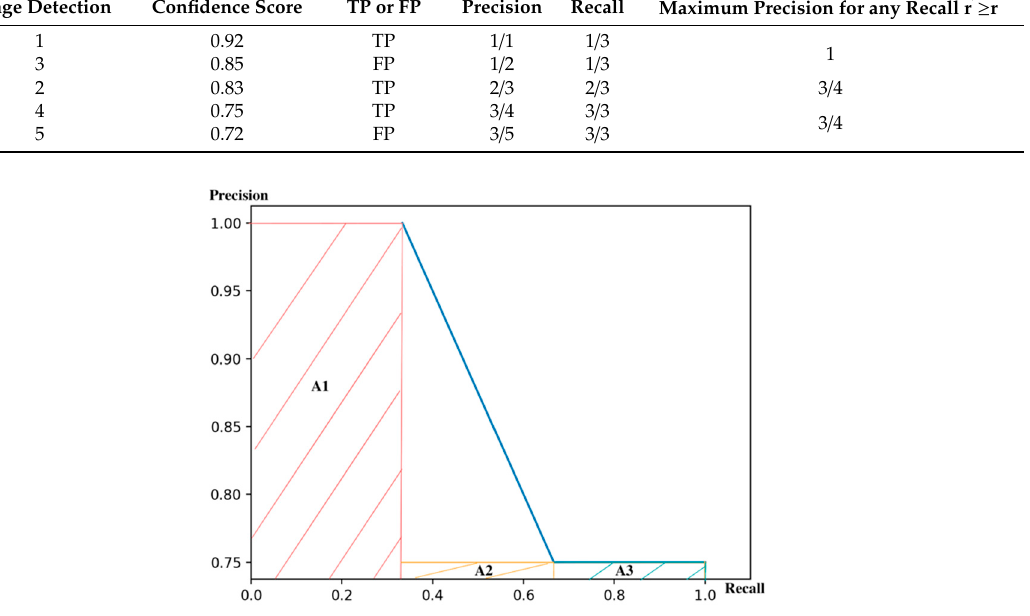
Figure 1. The precision/recall curve.